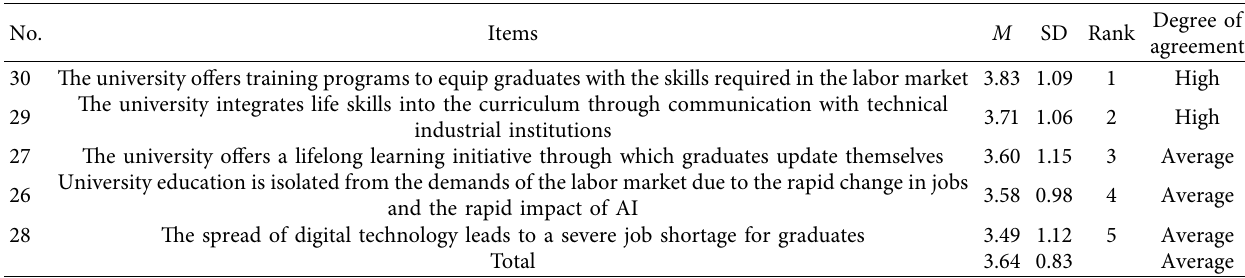
Table 8: Descriptives of the “graduates” subdimension in descending